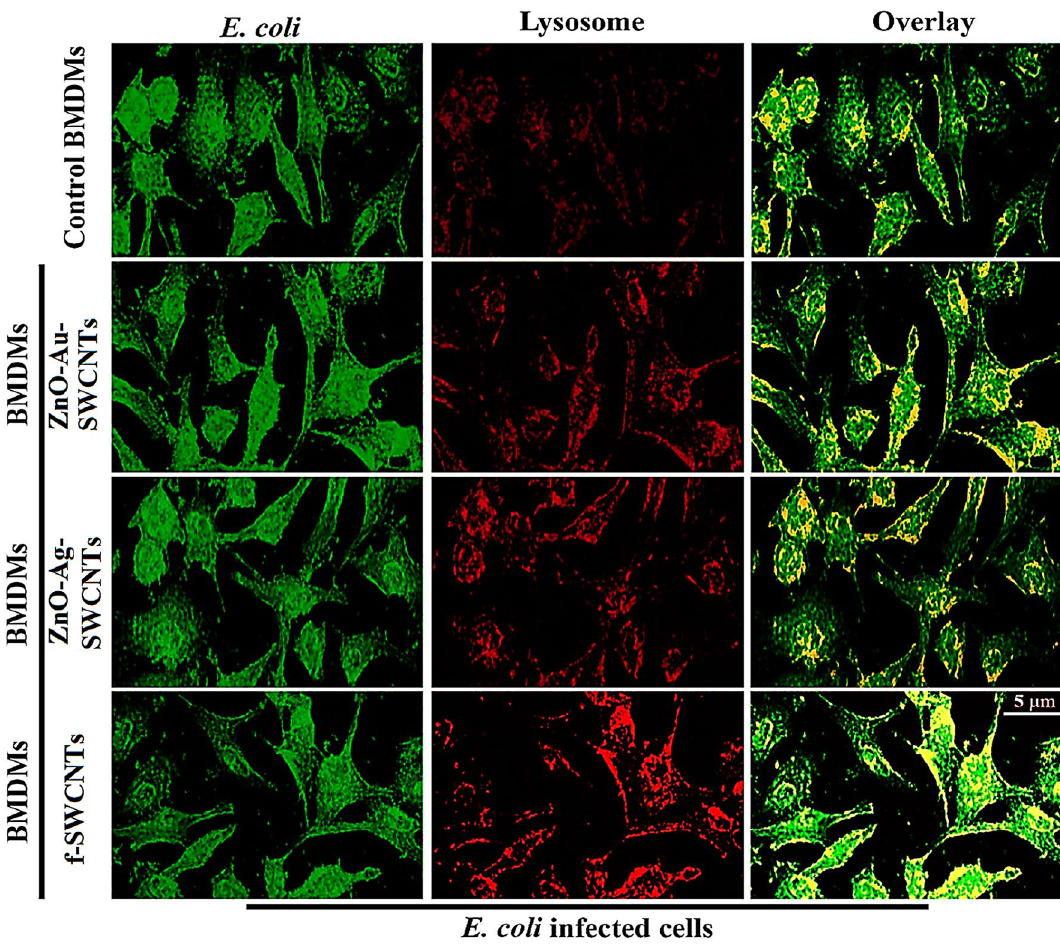
Figure 7. The prepared NPs increased the co-localization of the lysosomes and fluorescein isothiocyanate (FITC)-conjugated E. coli . co-localization appears as yellow, and lysosomes labelled with LysoTrackerRed® appeared red. Scale bar, 5